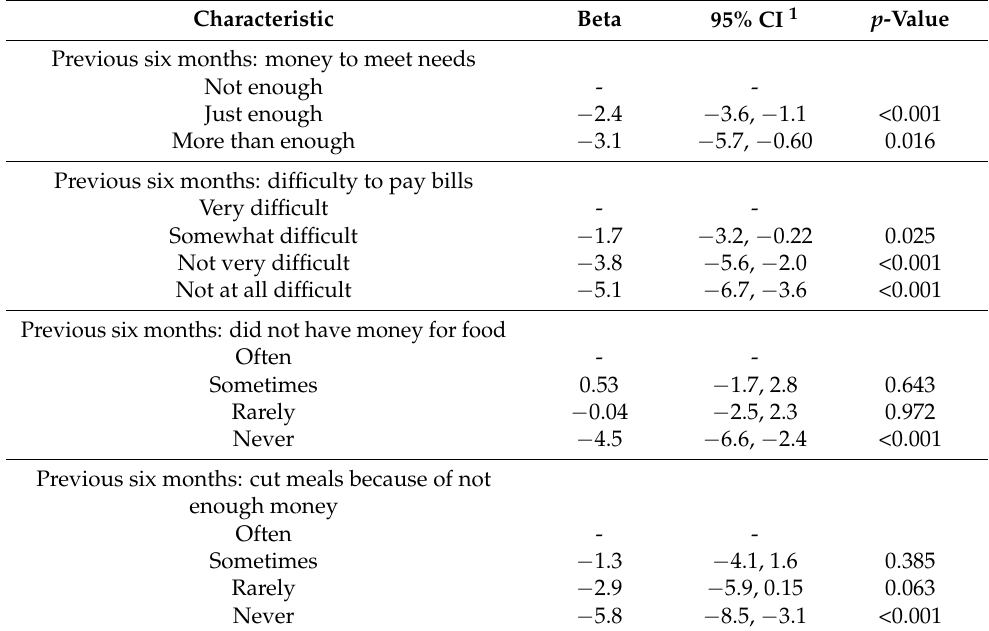
Table 2. Results from Linear Regression Models on Perceived Stress.